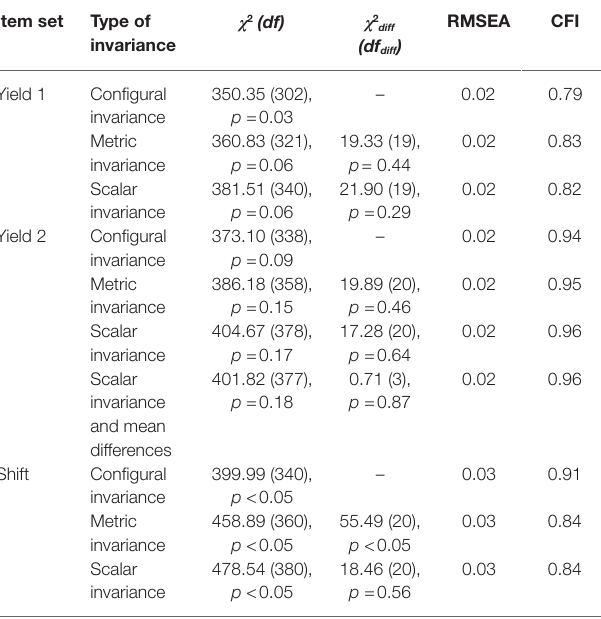
TABLE 9 | Fit of models for the investigation of measurement invariance for research institution.